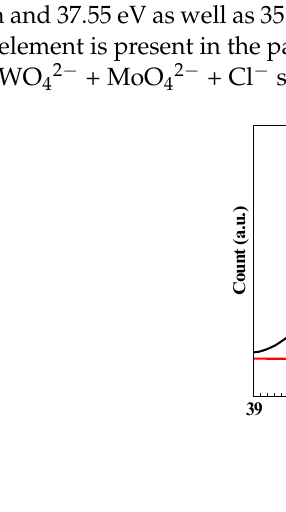
Figure 8. High-resolution XPS of W 4f for Q235 samples polarized to E p in WO 4 2− + Cl − and WO 4 2− + MoO 4 2− + Cl − solutions: ( a ) WO 4 2− + Cl − solution and ( b ) WO 4 2− + MoO 4 2− + Cl − solution. Figure 9 shows the high-resolution XPS of Mo 3d for Q235 samples polarized to E p in MoO 4 2− + Cl − and WO 4 2− + MoO 4 2− + Cl − solutions. Similar to W 4f, Mo 3d also exhibits spin-orbit splitting double peaks: at 235.70 and 232.40 eV in MoO 4 2− + Cl − solution, and at 235.80 and 232.70 eV in WO 4 2− + MoO 4 2− + Cl − solution.